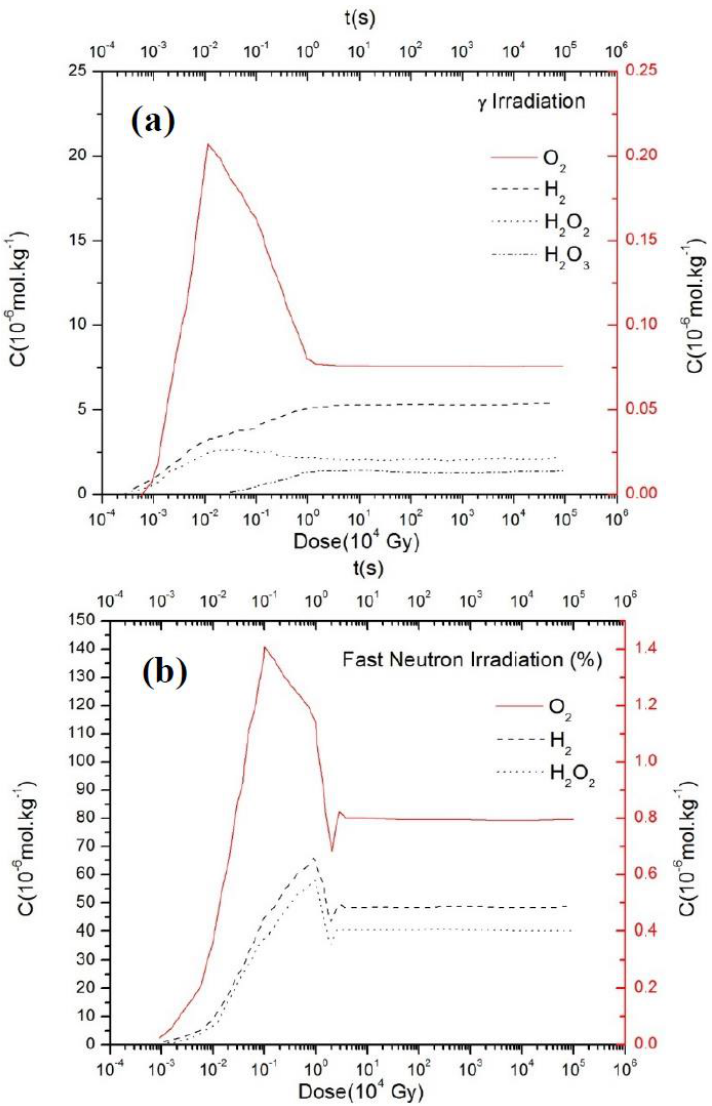
Figure 21. Calculated concentrations of H 2 , O 2 , H 2 O 2 and “H 2 O 3 ” as a function of dose of γ -radiation ( a ) and fast neutrons ( b ) at a dose rate of 10 kGy/s at 250 °C (after Kritsky et al. [27]). © 2001 ITER Organization. This image is hereby used courtesy of the ITER Organization.